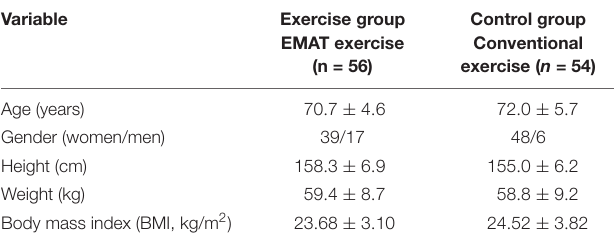
TABLE 2 | Demographic characteristics of the study participants.